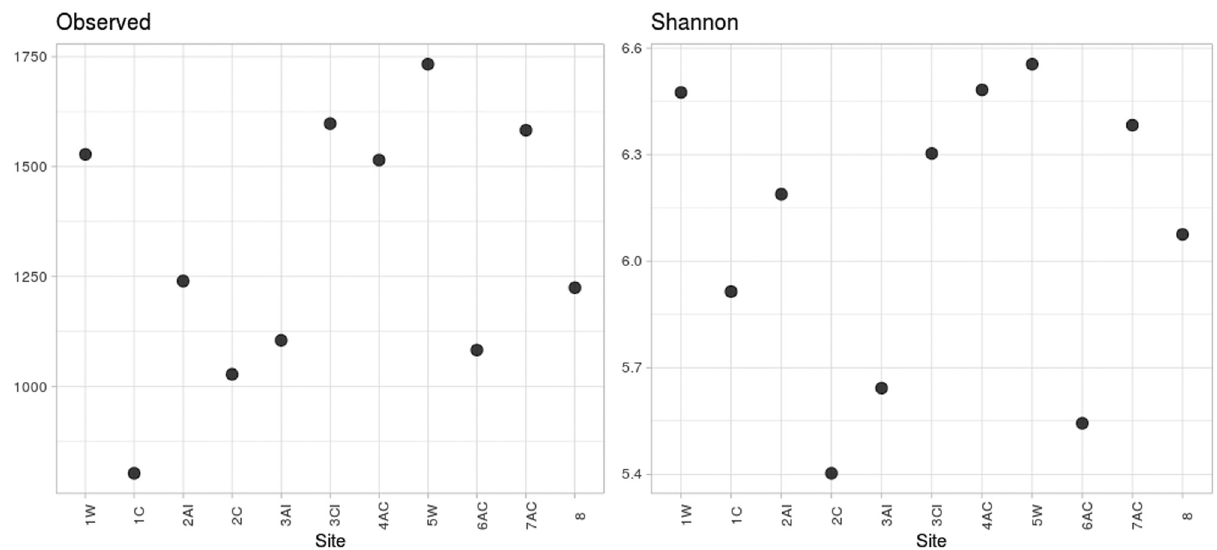
Figure 3: Alpha biodiversity indexes: number of OTU ( Observed – the number of “ species ” that are in the sample ) and Shannon index ( uniformity of representation of “ species ” ) . A larger index indicates a greater species diversity in the